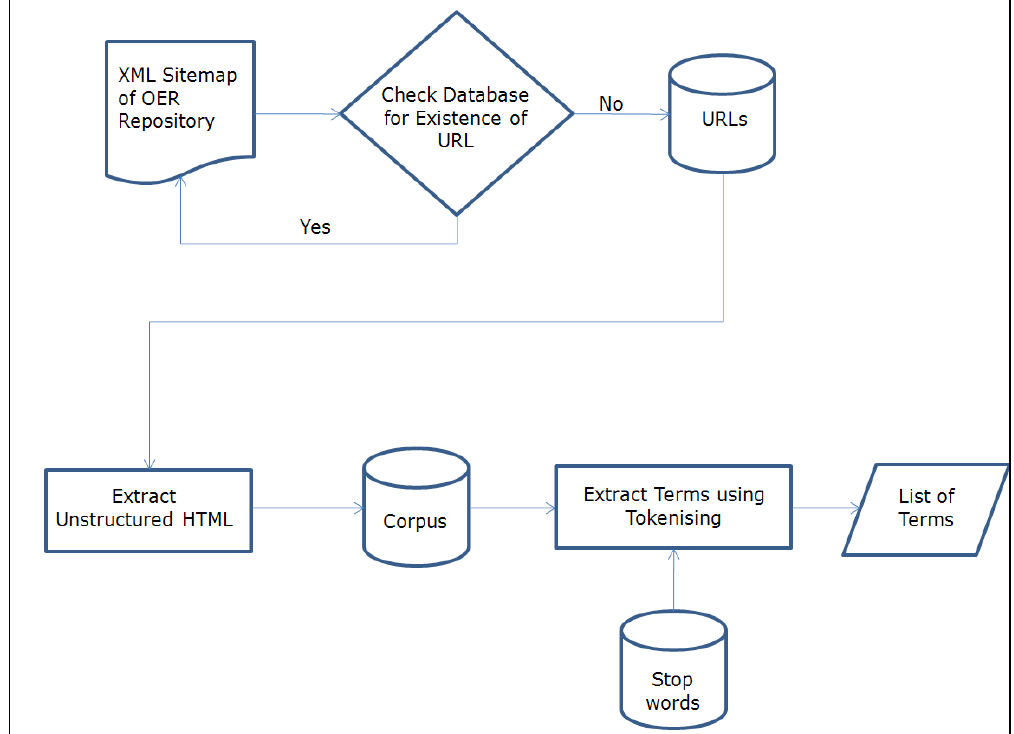
Figure 2 . The list of terms is created by tokenising the corpus using the stop words found in the Onix Text Retrieval